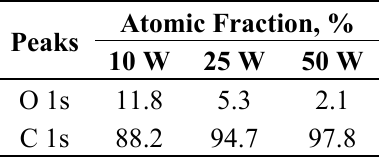
Table 2. Elemental composition of pp–GT thin films deposited at various RF power.